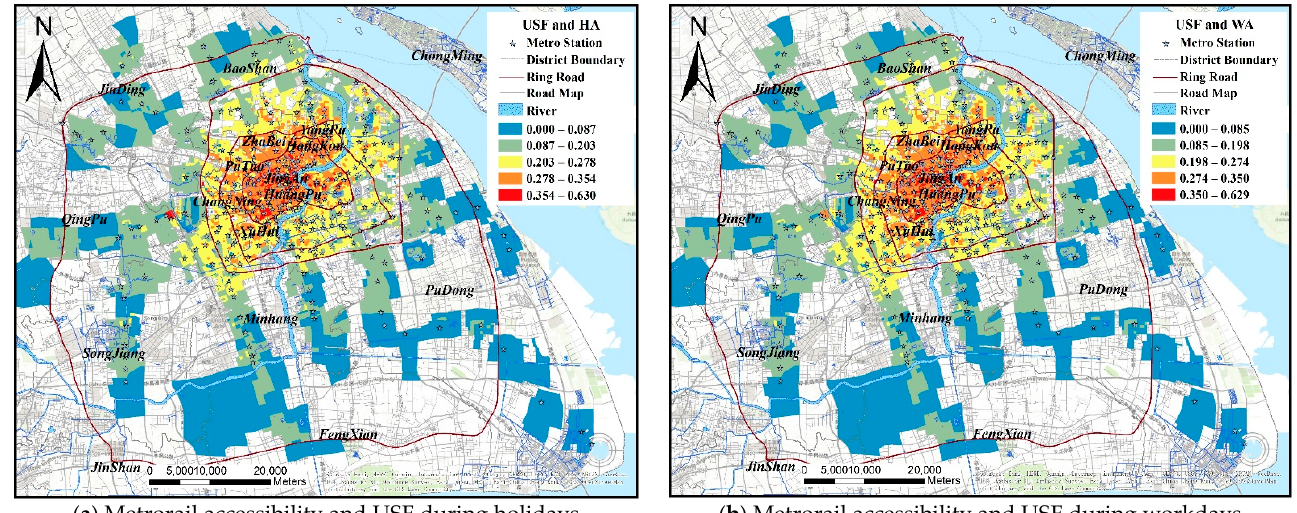
Figure 7. Spatial Coordination between metrorail accessibility and urban spatial form.